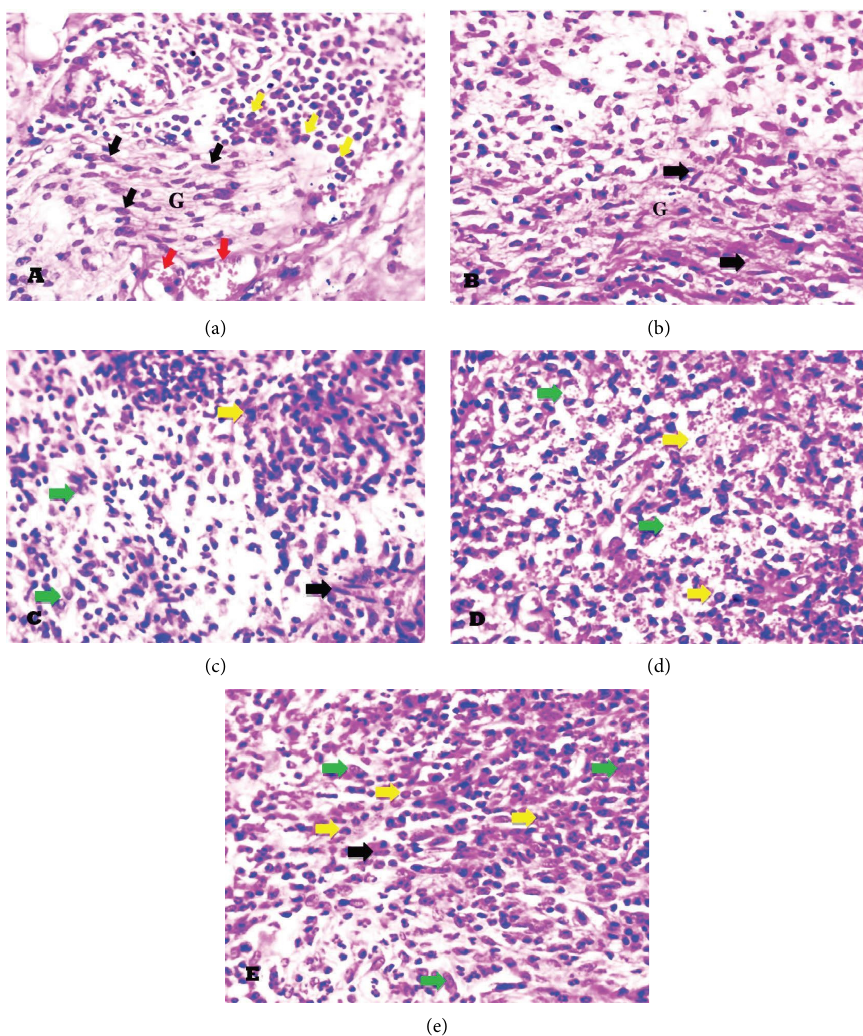
Figure 5: Histological sections from the skin of BALB/c mice infected with L. major and treated with luteolin/AgNPQct ointment (a), AgNPQct (b), and luteolin (c) for 21 days compared to the untreated (d) and glucantime (e) groups (H&E, × 400). Black arrow: fbroblast, red arrow: blood vessel, green arrow: amastigotes, and yellow arrow: